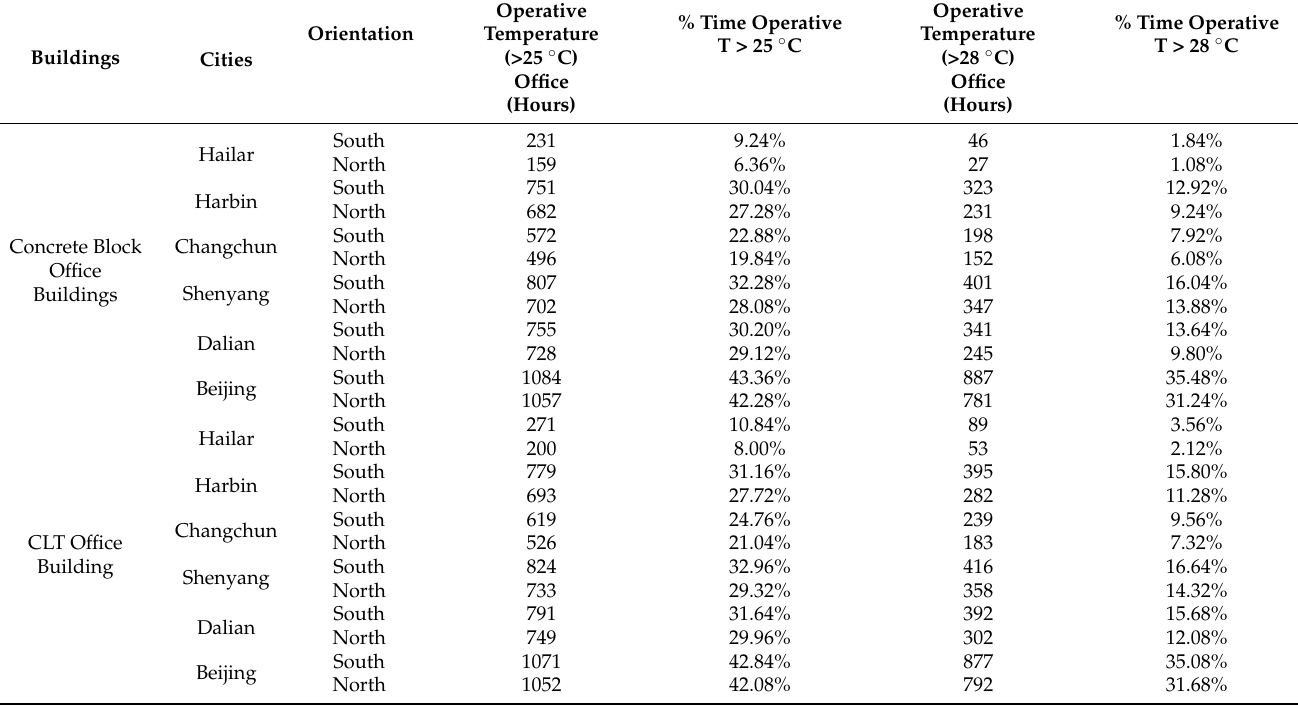
Table 11. Assessment of overheating in concrete brick and CLT buildings (7th floor south S6 room) based on CIBSE TM A.